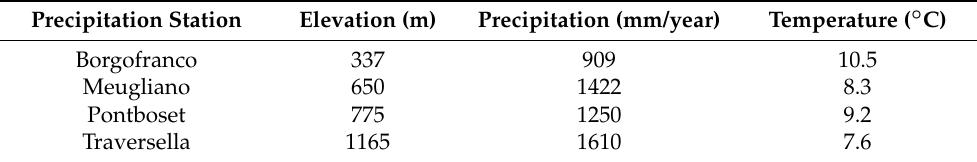
Table 1. Inter-annual average precipitation and temperature values for each rainfall station. Precipitation Station Elevation (m) Precipitation (mm/year) Temperature ( ◦ C) Borgofranco Meugliano Pontboset 775 Traversella